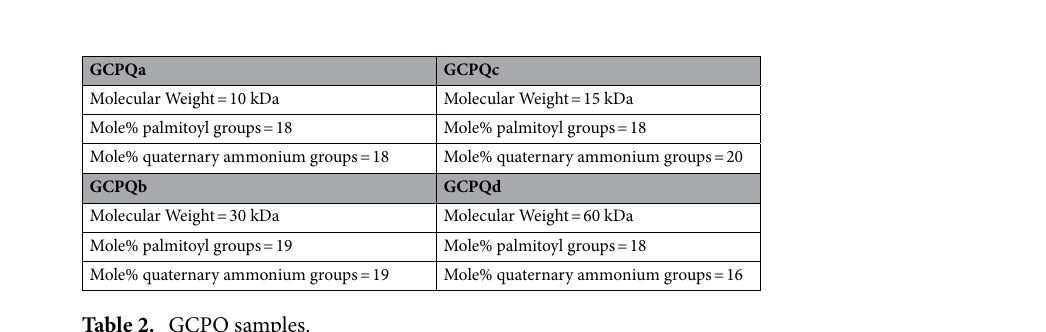
Table 1. Real-time qPCR oligonucleotides.